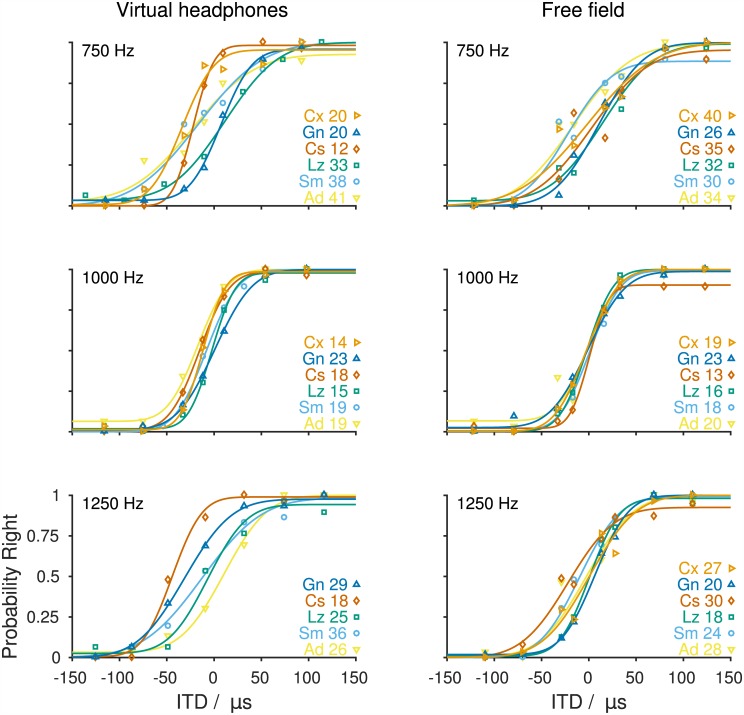
Probability of responses to the right as a function of ITD at 750, 1000, and 1250 Hz. The left column shows the performance using virtual headphones. The right column shows the free-field performance depending on the ITDs occurring in the free-field experiments.Symbols indicate individual performance of animals [750 Hz: n = 6 (vhp, free-field), 1000 Hz: n = 6 (vhp, free-field), 1250 Hz: n = 5 (vhp) and 6 (free-field)]. Lines represent the cumulative normal distribution functions with four parameters (slope, inflection point, offset from 0, offset from 1) fitted to the raw data of individual animals. Identical colors and symbols represent data and fit of the same individual animal in the different panels. Thresholds (in μs) and identifiers of individual animals are given on the right.